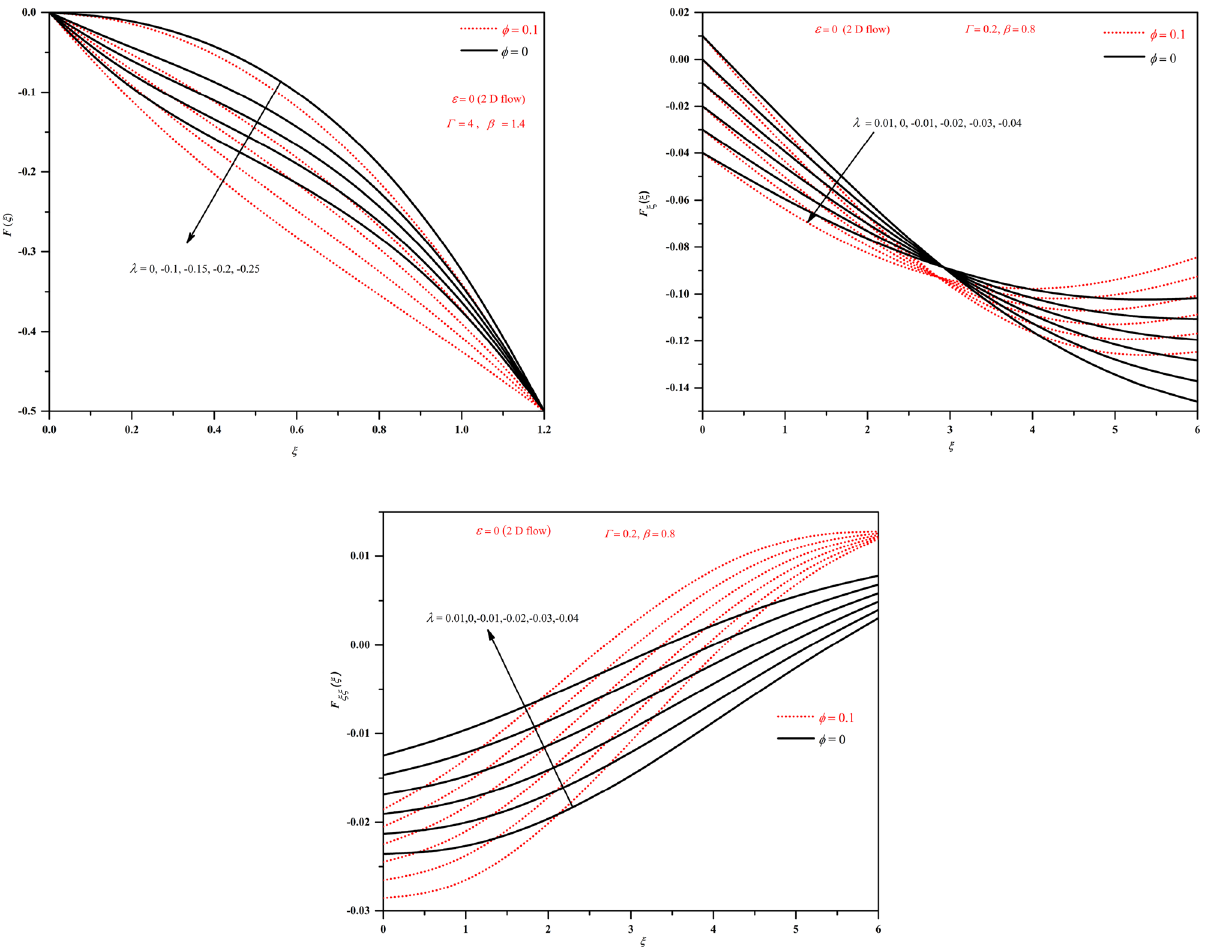
Figure 4. Plots of F , F ξ and F ξξ by varying (cid:31) (shrinking wall (cid:31) < 0 ) in the two-dimensional